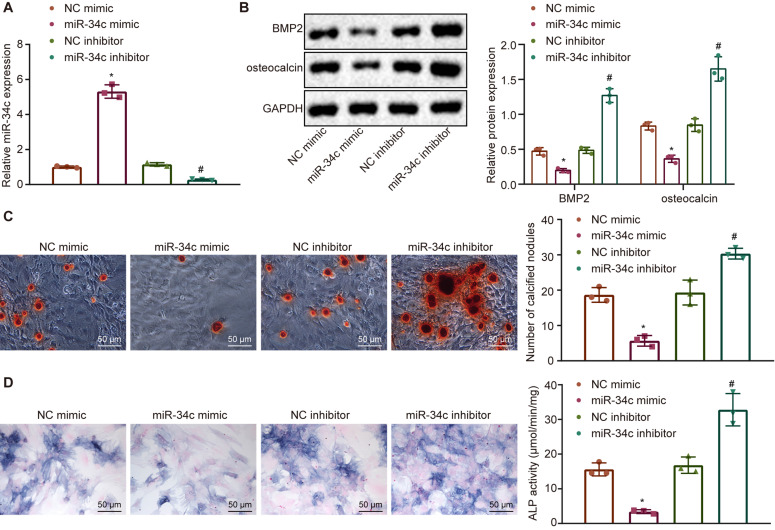
Inhibition of miR-34c expression suppresses osteogenic differentiation and VICs calcification. VICs were transfected with NC mimic plasmid, miR-34c mimic, NC inhibitor plasmid or miR-34c inhibitor. (A) miR-34 expression measured by RT-qPCR in VICs after different transfection treatment. (B) Protein expression of BMP2 and osteocalcin measured by western blot analysis in VICs after different transfection treatment. (C) Alizarin red staining (×200) for calcification in VICs after different transfection treatment. (D) ALP staining (×200) and quantitative ALP activity analysis in VICs after different transfection treatment. Data are expressed as mean ± standard deviation from at least three independent experiments. The comparison between two groups was checked by unpaired Student’s t test. *p < 0.05 vs. VICs transfected with NC mimic. #p < 0.05 vs. VICs transfected with NC inhibitor.